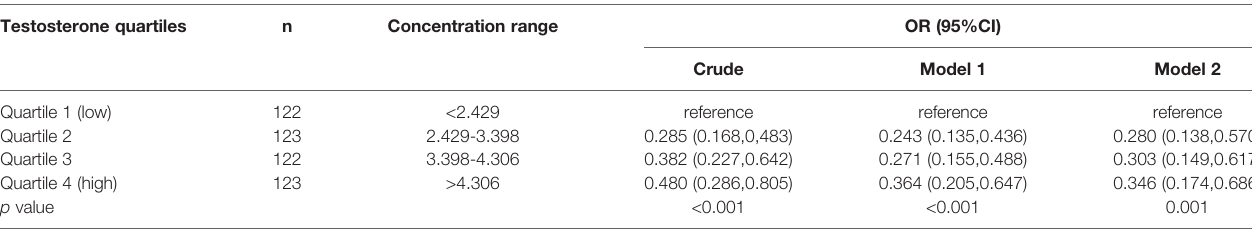
TABLE 3 | Association of CAD with serum total testosterone in T2DM men.